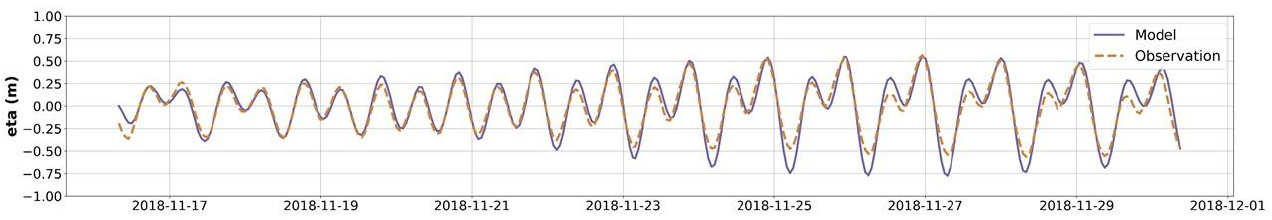
Figure 5. Modeled (blue curves) and measured (red dots) surface elevation at Sicao tidal gauge versus time.